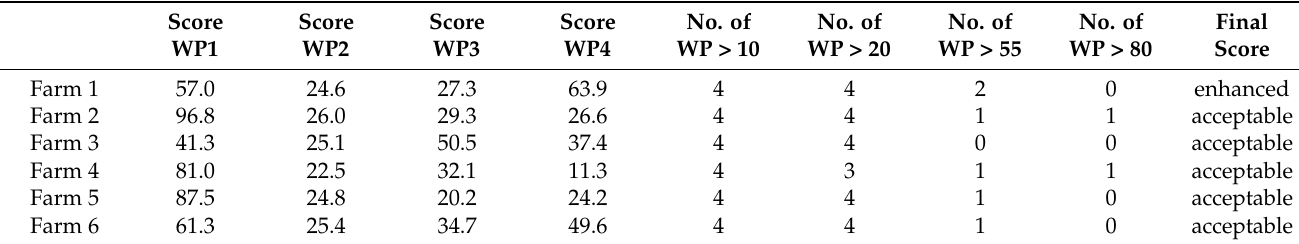
Table A2. Scoring of WP 1–4 and determination of final welfare